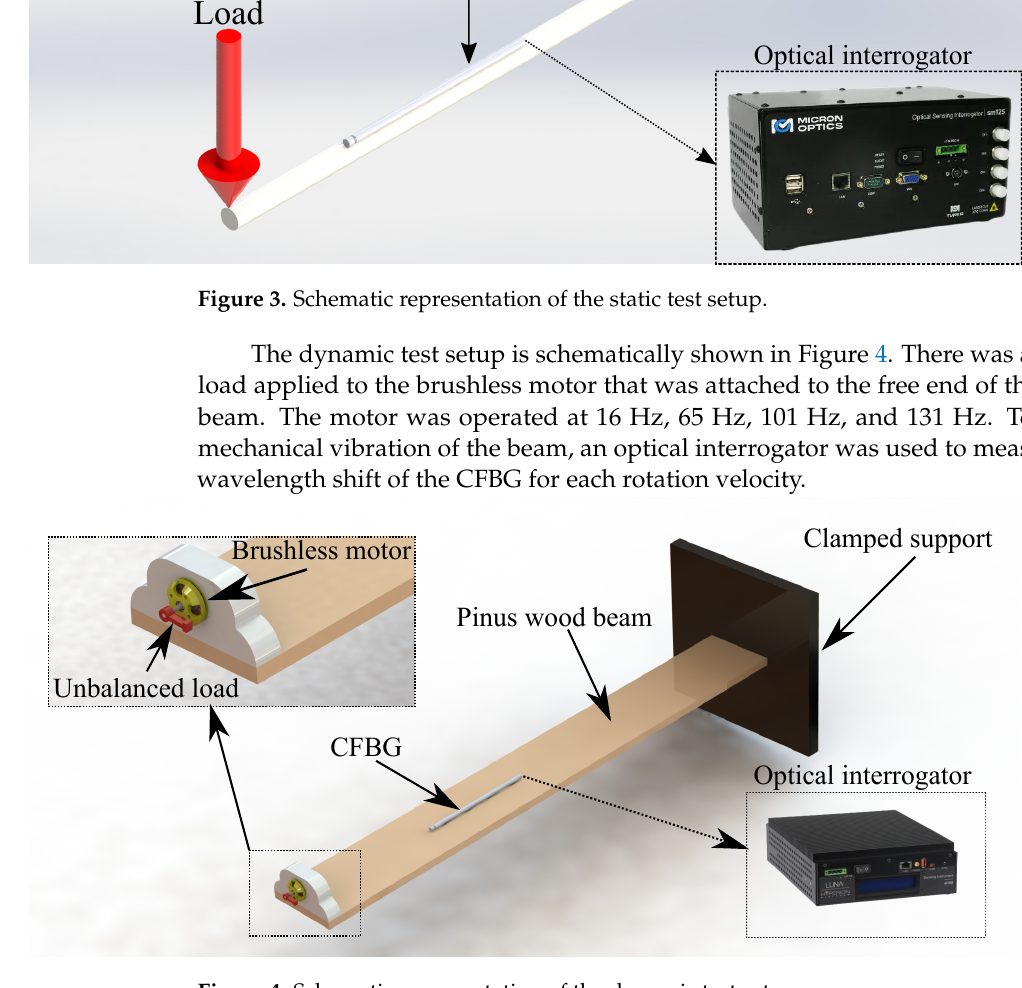
Figure 4. Schematic representation of the dynamic test